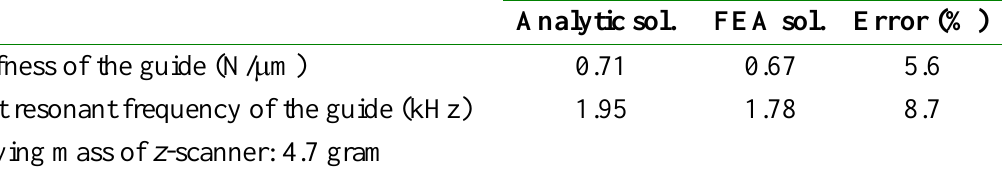
Table 3. Comparison between the optimal and FEA solutions.